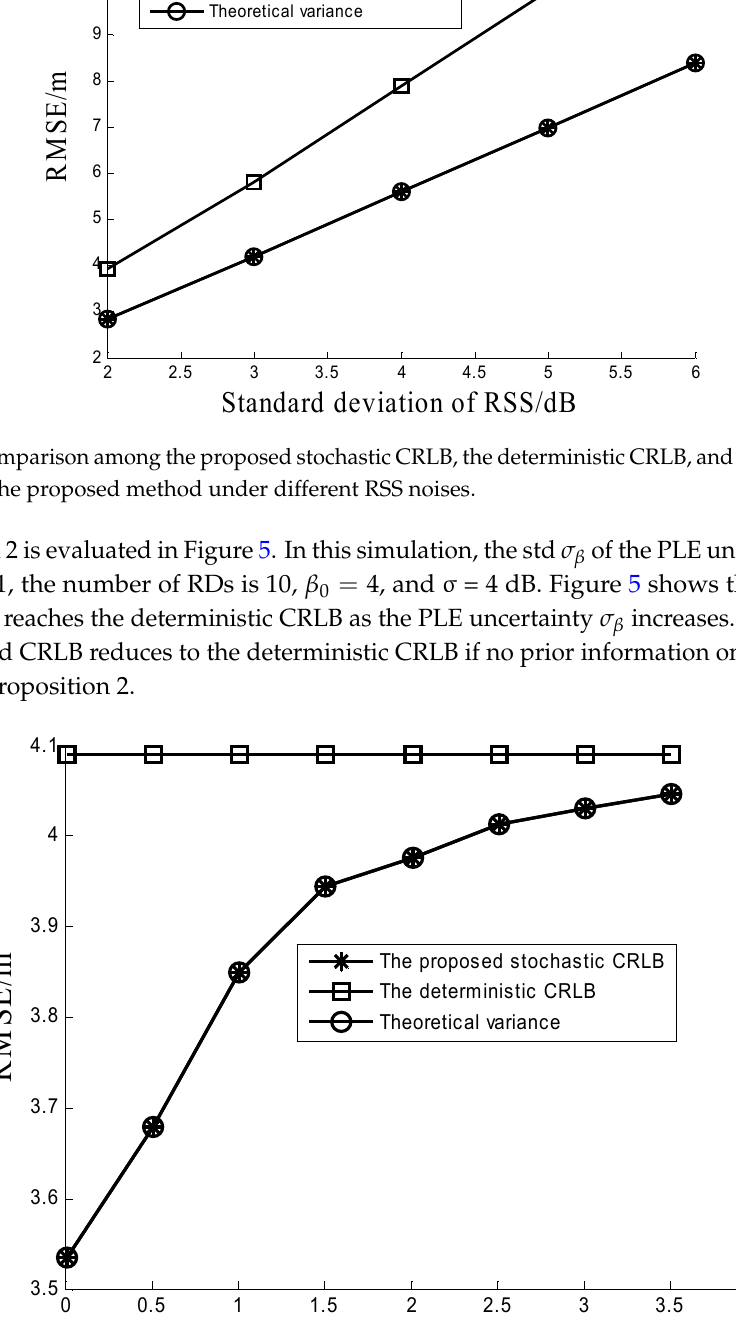
13 of 22 Figure 3. Performance comparison under different numbers of RDs. Figure 4 is performed to verify Propositions 1 and 3. The simulation environments of Figure 4